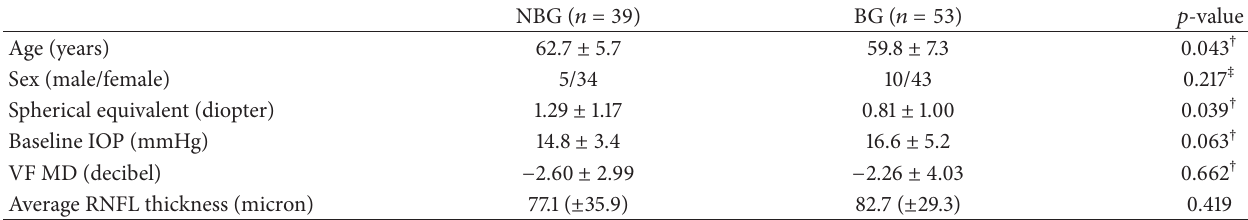
Figure 2: Categorization of primary angle closure eyes according to the location of iris root insertion. (a) Basal insertion (upper; dark, lower; light lighting conditions). (b) Nonbasal insertion (upper; dark, lower; light lighting conditions). Table 1: Demographic features and baseline status of the study subjects.